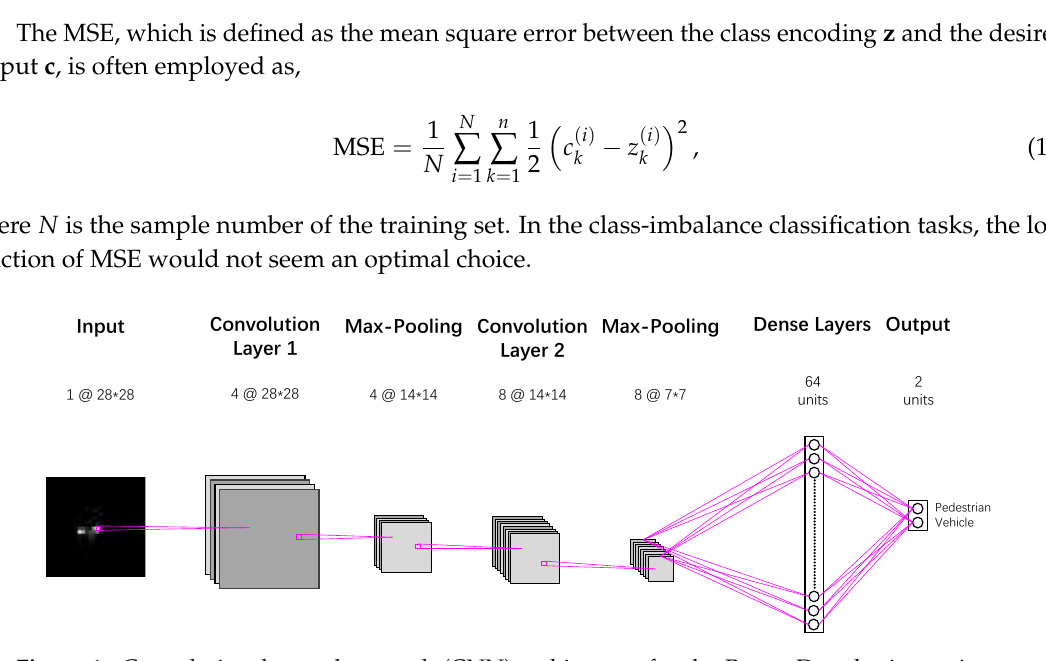
Figure 1. Convolutional neural network (CNN) architecture for the Range-Doppler image input. This CNN architecture with two convolutional and one fully-connected layer is kept identical for all